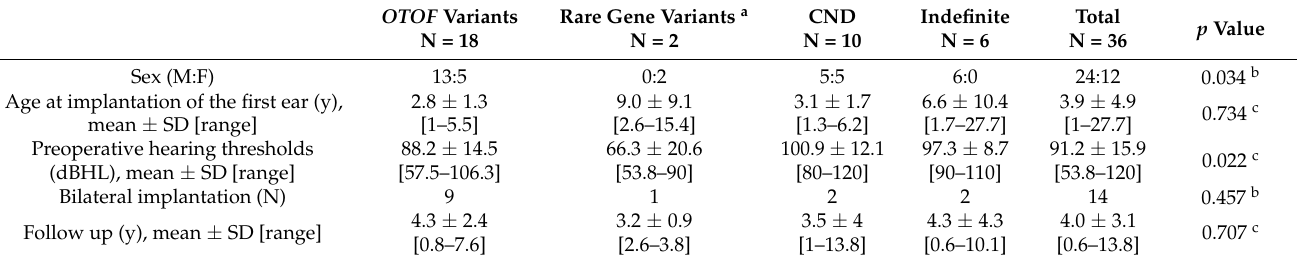
Table 2. Basic characteristics of patients with auditory neuropathy spectrum disorder in different groups.